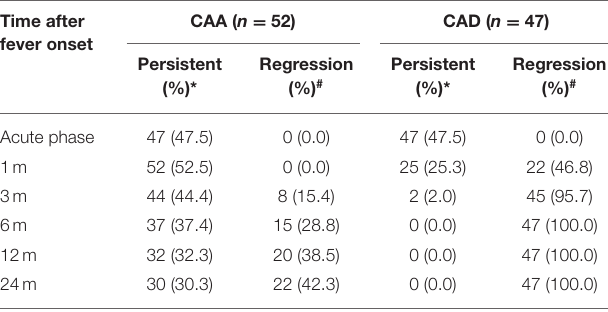
TABLE 1 | The CALs status of all KD patients at different time points during the 2-year follow-up. Time after CAA ( n = 52) fever onset